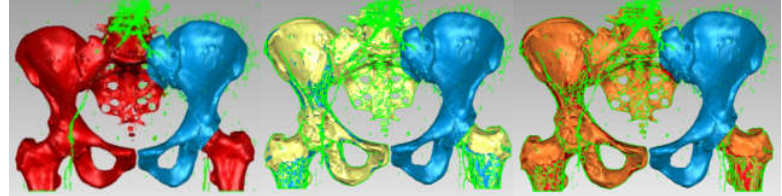
Figure 23. Steps in Geomagic for obtaining the left iliac bone.